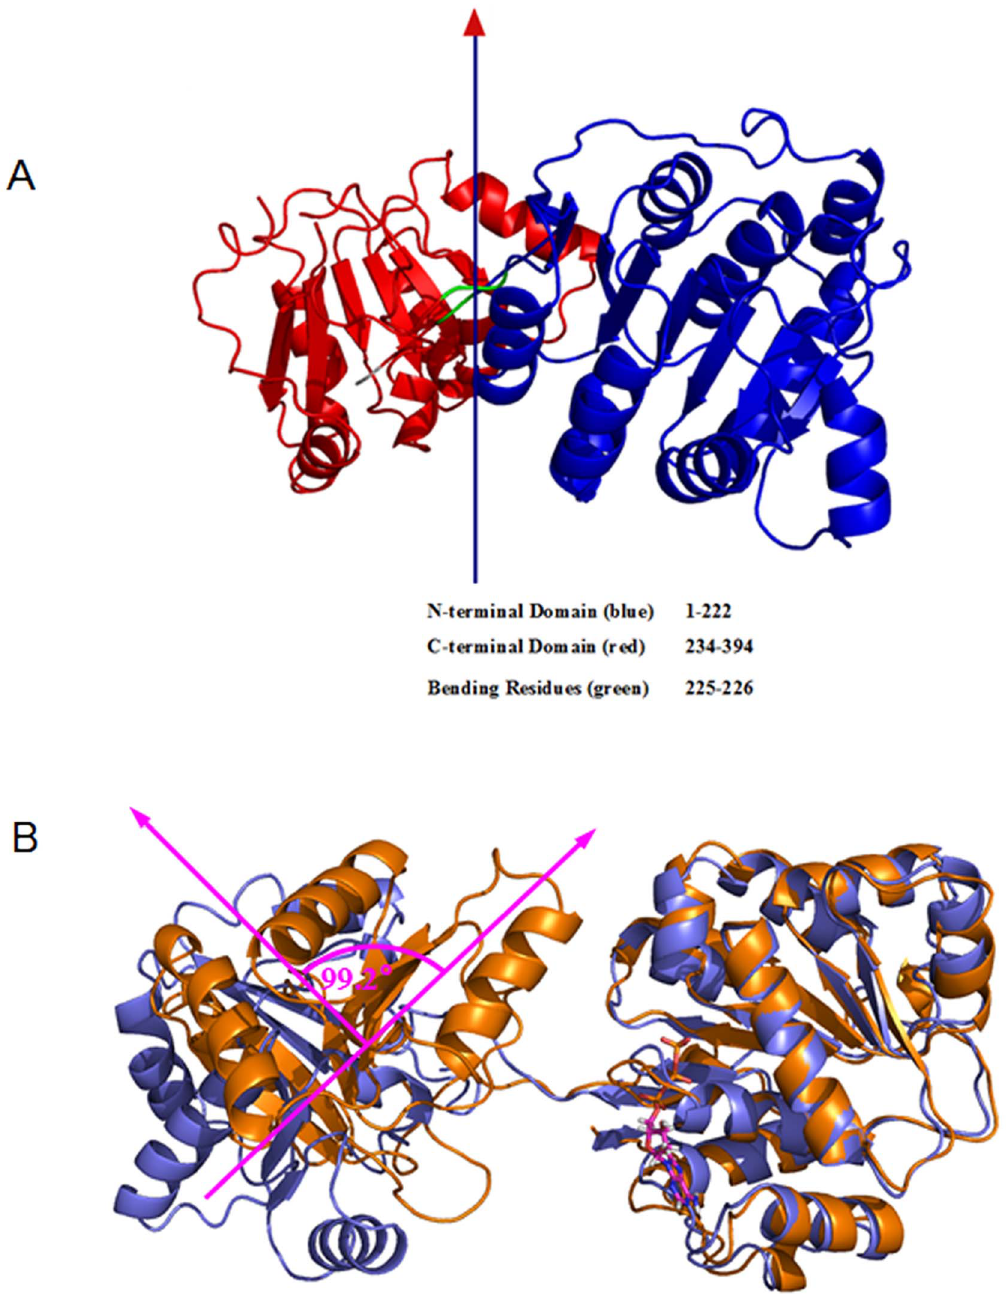
Figure 6. Domain rotation angel between the O-eIF4A and ATP + eIF4A models. (A) Dynamic domain identified between the O-eIF4A and ATP + eIF4A models. The residues forming the fixed domain, moving domain and bending residues are depicted in colors of blue, red and green, respectively, with a reference line crossing at the center of rotation. (B) The relative rotation angel of the two domains in the eIF4A protein between the O-eIF4A (slate) and ATP + eIF4A (orange) models. in Figure S2A–D. The first step entailed ATP-mediated shift in the results in structural changes of the N-domain – C-domain P-loop away from b 7 strand and close to both b 8 and a 3 segments interface and the RNA-binding regions at the N- and C- domains. with , 2.2 A ˚ movement distance along with the formation of At the N-domain – C-domain interface, the a 5- b 4 and b 3/6/7 hydrogen bonds at the ATP-binding region (see Figure 8). Such interface segments in the N-domain gradually move towards the a 3 and a 4/5 interface helices, respectively, in the C-domain. movement of the P-loop results in its open conformation, as reported experimentally [59]. Interestingly, the initial ATP Simultaneously, the residues Pro97, Thr98, Arg99, Gly125, binding causes a rotation of 99.2 u between the two domains of Gly126, Thr145, Gly147, Arg148 at the RNA-binding b 3- a 5/ b 4- b 5- a 6 region of N-domain and the residues Arg269, Ser291, protein relative to the O-eIF4A model (see Figure 6B), which